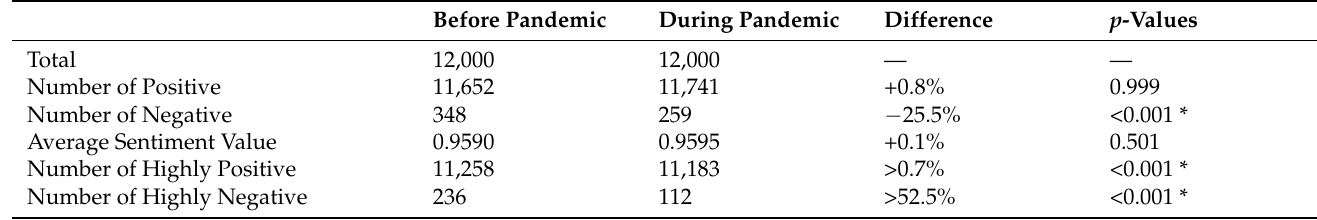
Table 1. The Numbers of Comments with Different Sentiments (Beijing). Before Pandemic During